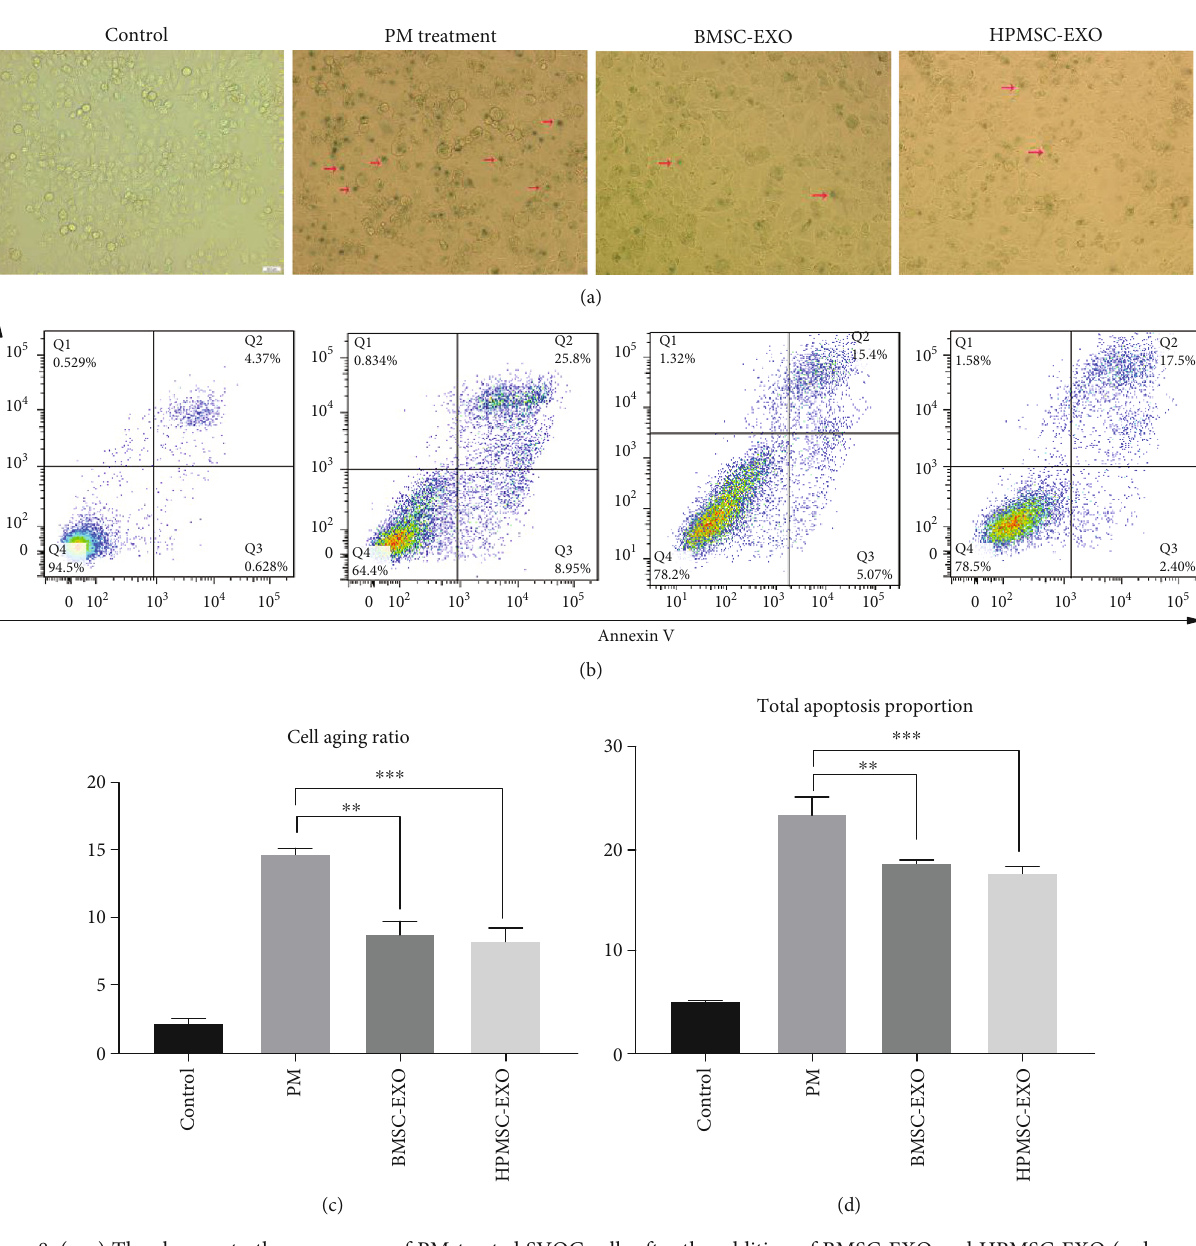
Figure 8: (a, c) The changes to the senescence of PM-treated SVOG cells after the addition of BMSC-EXO and HPMSC-EXO (red arrows indicate typical senescent cells). The di ff erences were statistically signi fi cant. ∗∗ P < 0 : 01 ; ∗∗∗ P < 0 : 001 . (b, d) The changes to the apoptosis of PM-treated SVOG cells after the addition of BMSC-EXO and HPMSC-EXO. The calculation formula of the total proportion of apoptosis was (the total apoptosis calculated as ( Q2 + Q3 )). The di ff erences were statistically signi fi cant. ∗ P < 0 : 01 ; ∗∗∗ P < 0 : 001